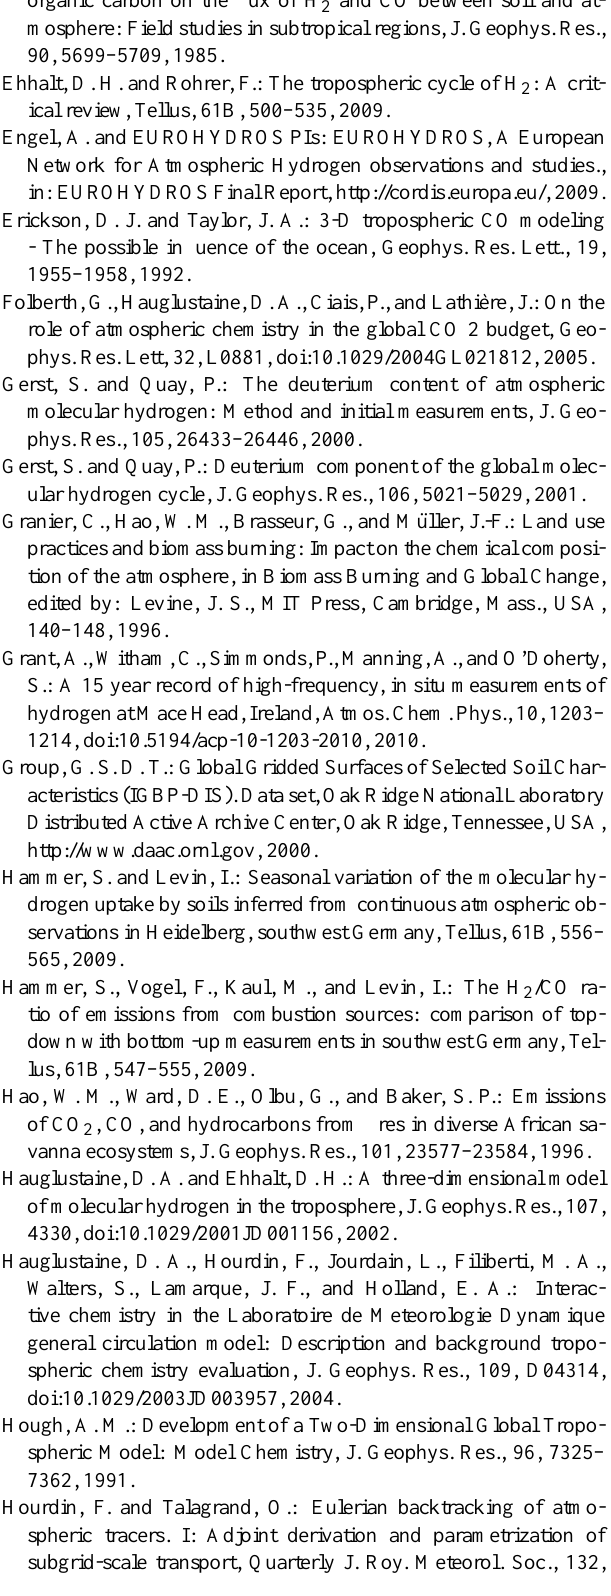
Atmospheric Hydrogen Observations and Studies”. RAMCES is funded by INSU and